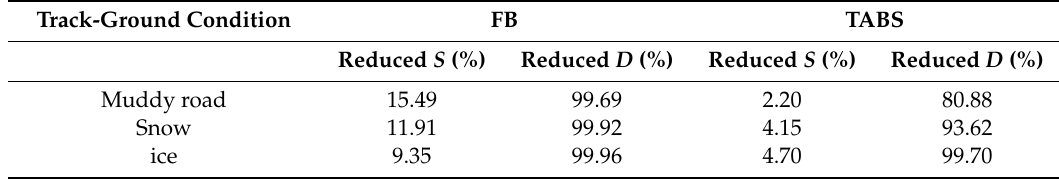
Table 5. The enhancement by using SMSCR compared with FB and